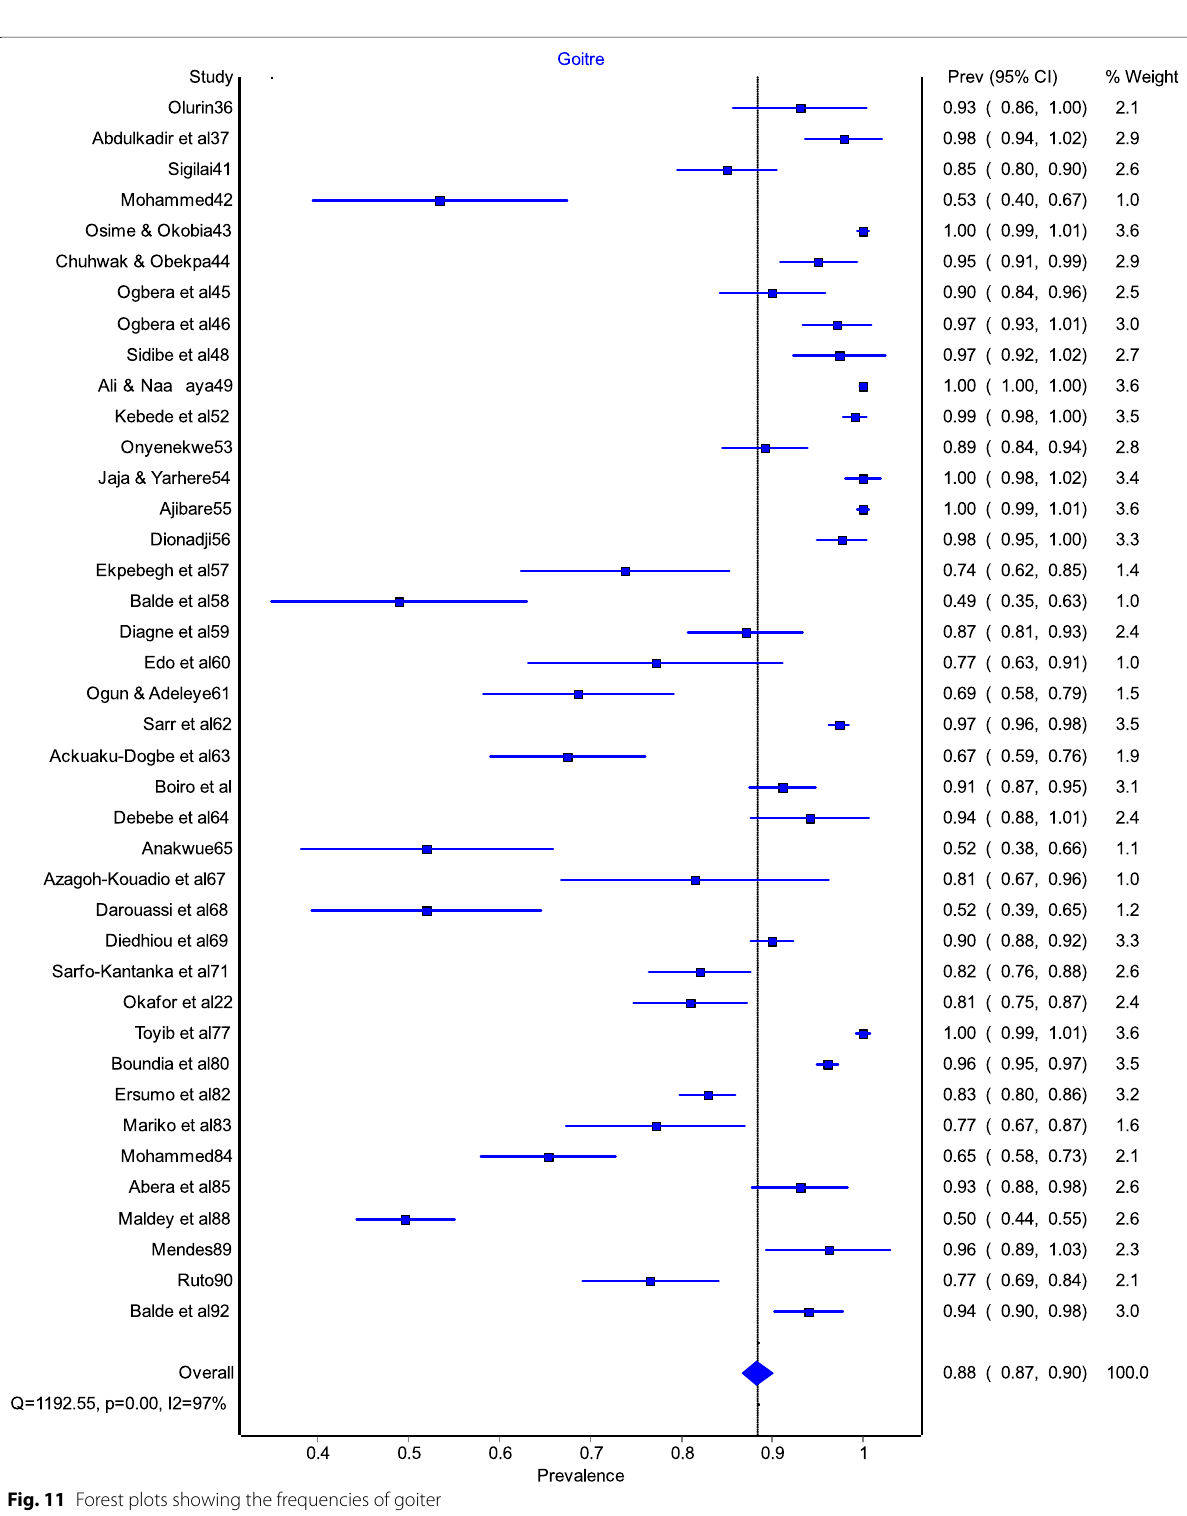
Fig. 11 Forest plots showing the frequencies of